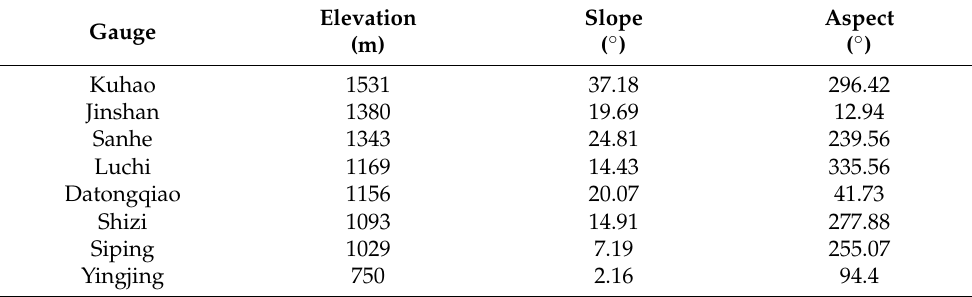
Table 1. The terrain information of all rain